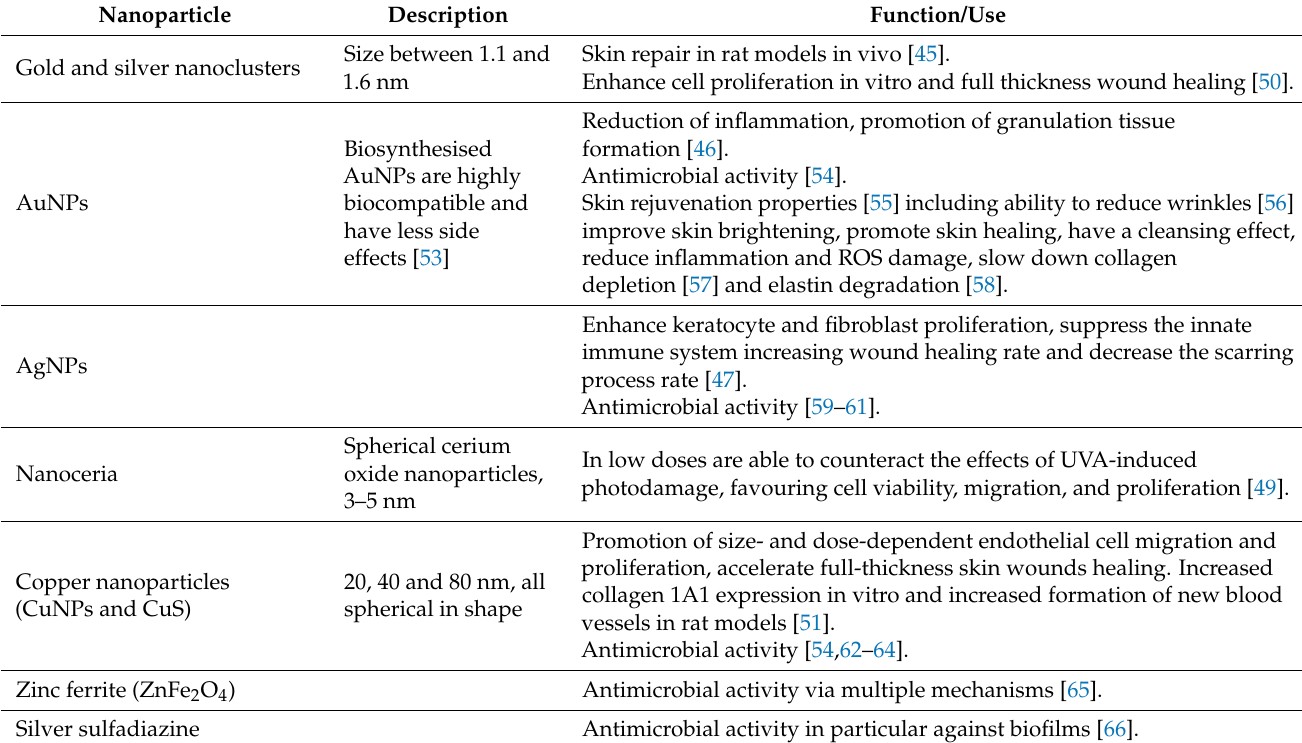
Table 2. Nanoparticles mainly used for skin regeneration and rejuvenation, and their functions. Nanoparticle Description Gold and silver